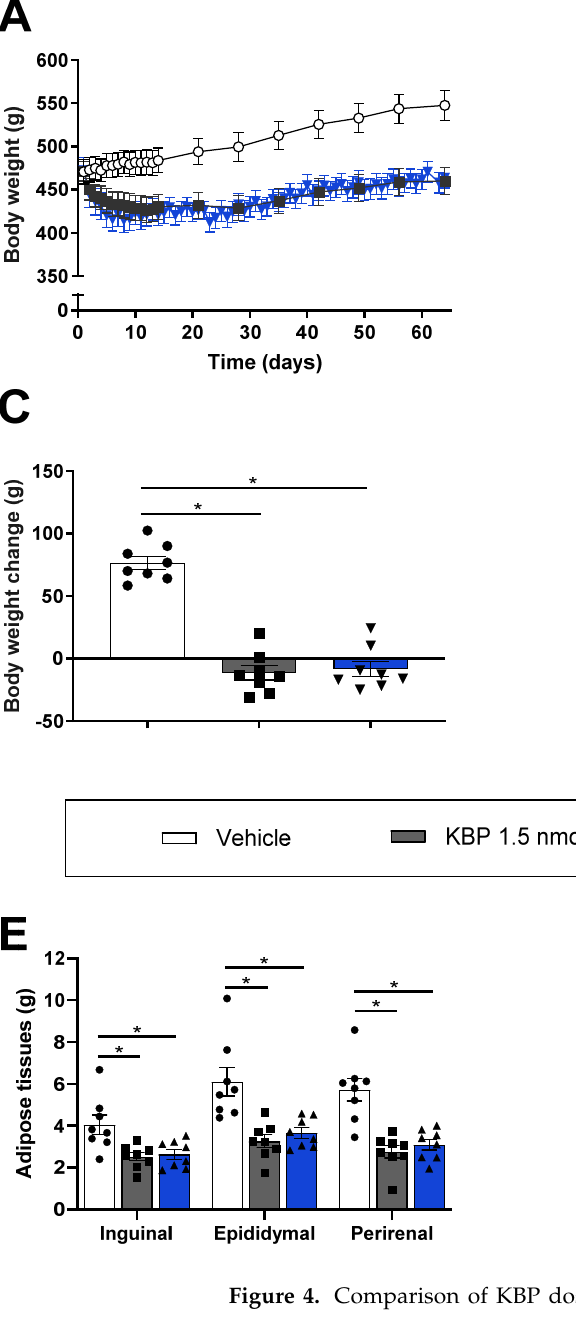
Figure 4. Comparison of KBP dosed daily (1.5 nmol/kg QD) and KBP-A dosed every 3rd day (4.5 nmol/kg Q3D) in HFD Sprague–Dawley rats. ( A ) Body weight and ( B ) food intake during the study.